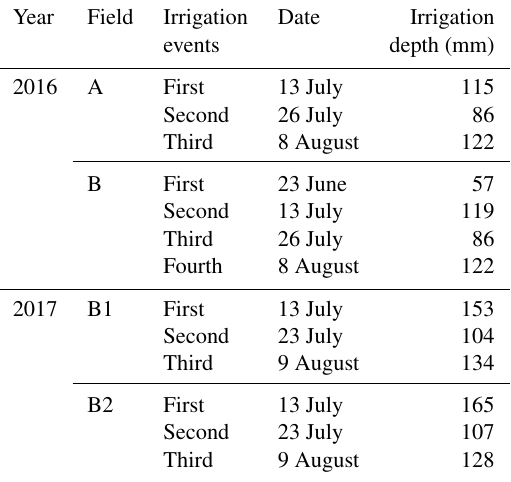
Table 2. Irrigation scheduling carried out at Fenzidi experimental fields in 2016 and